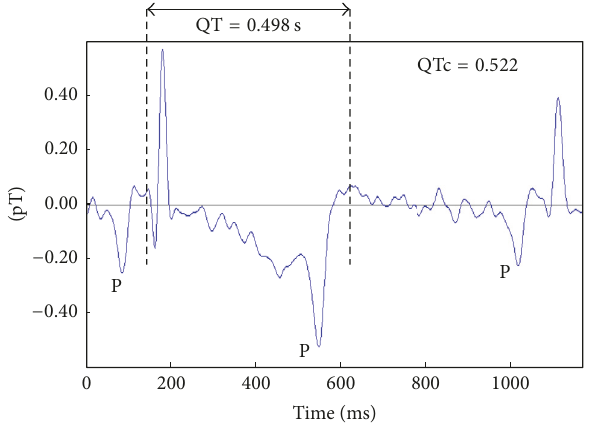
Figure 1: fMCG waveform at 30 weeks’ gestation. QT interval was extremely prolonged (normal QT interval of the same gestational week:0.248 ± 0.316 s[6]).Pwavesshowedthesamemorphologyand polarity. They were observed before the QRS complex and also in the posterior half of the T wave without following the QRS complex, which indicates a functional 2 :1 AVB related to QT prolongation.